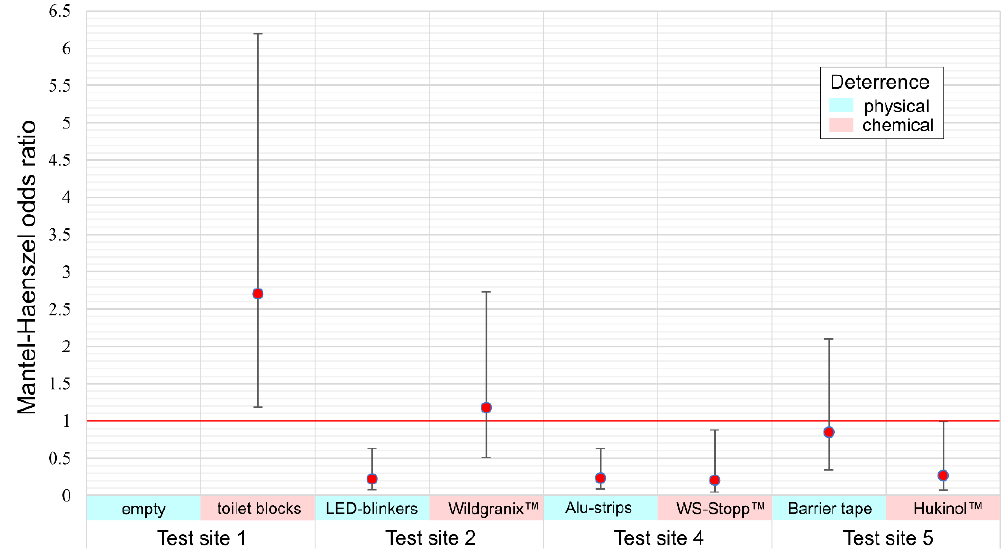
Figure 5. Mantel-Haenszel odds ratios with 95% confidence intervals relative to control.